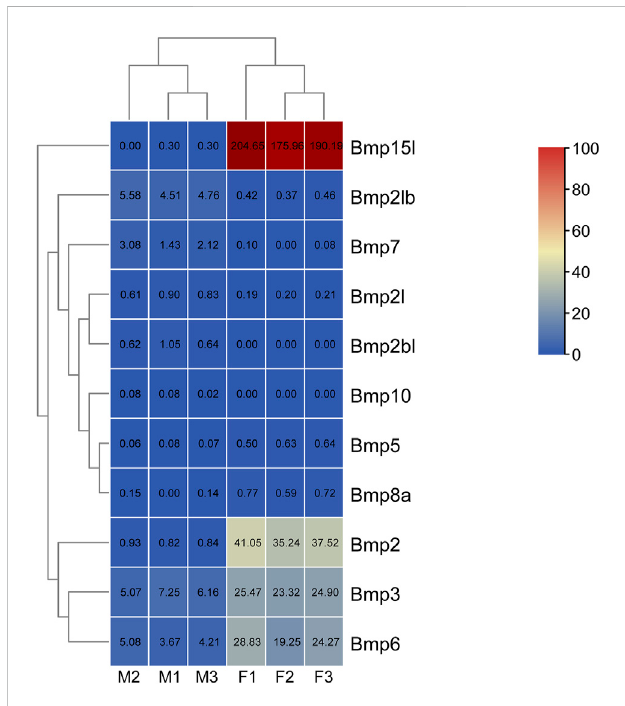
FIGURE 10 ExpressionanalysisofBMPgenesin P . sinensis .Theexpressionlevels ofBMPgenesarepresentedwithFPKMvalues.Thecolorscalerangesfrom 0 to 100,red indicates highexpression, and blueindicateslow expression.